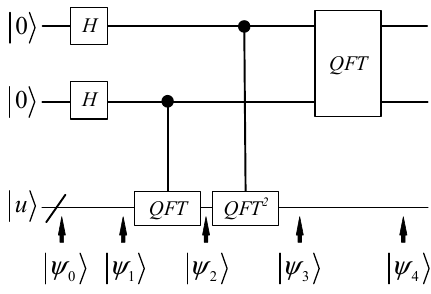
Figure 1. The QPE for Equation (7).